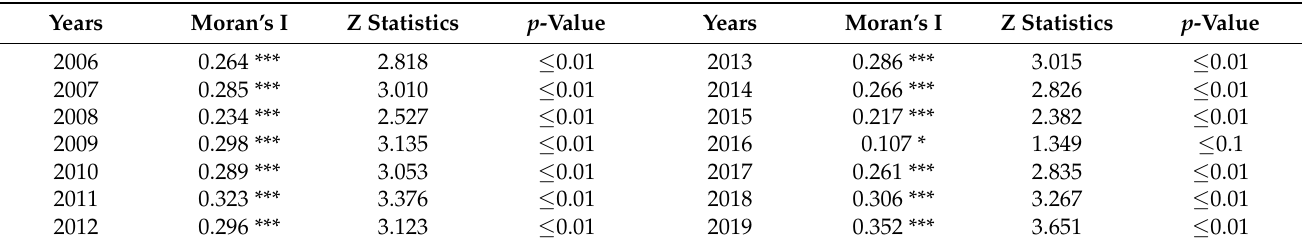
Table 6. Moran’s I test results of the global Moran index for the development level of green